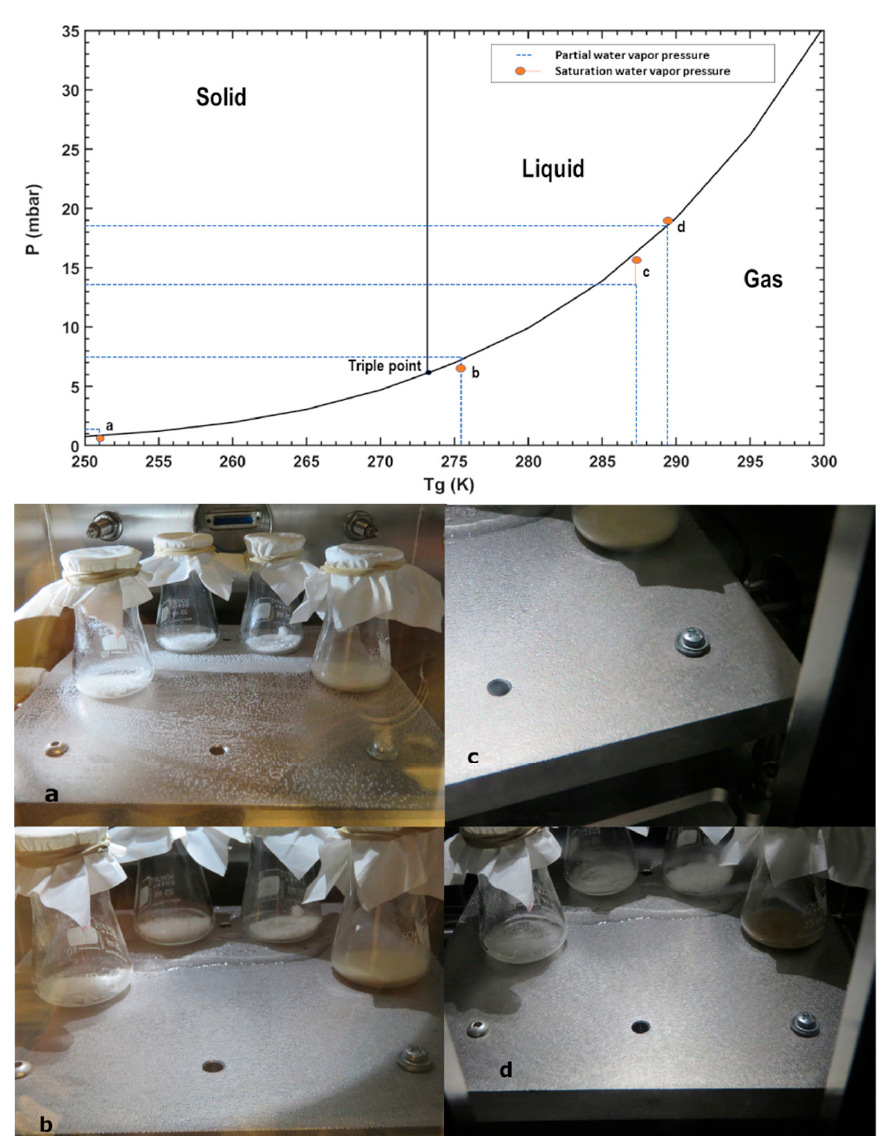
Figure 4. ( Top ) Derived partial water vapor pressure, T g conditions and saturation water vapor pressure ew ((cid:2904)(cid:2917)) for liquid or ice. The surface RH g was always close to 100% during this experiment, and the air was still drier. ( Bottom ) The series of images taken during the experiment shows first the formation of frost, then liquid water droplets, and a meandering narrow water flow that prevails for longer than the droplets. ( a ) As the water is added and the table temperature was lowered to 250 K, it starts to form frost. ( b ) With a gradual increase in the temperature as it passes through the triple point of water, the stable droplets appear on the table. ( c ) Then, as the temperature T g increases to 287 K, the droplets start to disappear on the sides of the table. ( d ) Finally, most of the droplets evaporated as the table reached 289